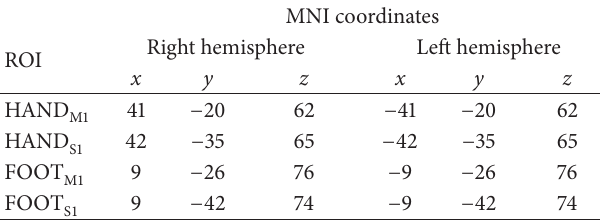
Note . Coordinates represent locations of peak voxels (cf. [26]) as centers for the construction of spherical masks with radius 8 mm. Due to overlapping spheres in the primary motor and primary somatosensory feet areas, the coordinates of the x -axis were slightly modified from originally 6 to 9 (right) and − 6 to − 9 (left) in M1 and 10 to 9 (right) and − 10 to − 9 (left) in S1, respectively. M1, primary motor cortex; S1, primary somatosensory cortex; MNI, Montreal Neurological Institute space; ROI, region of